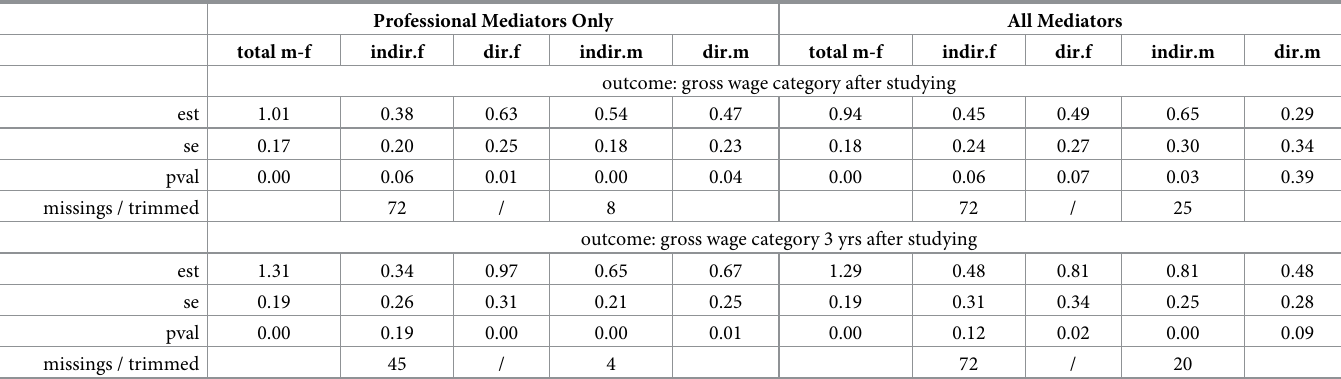
Table 8. Disentangling the contributions of professional and personal mediators (trimming equal to